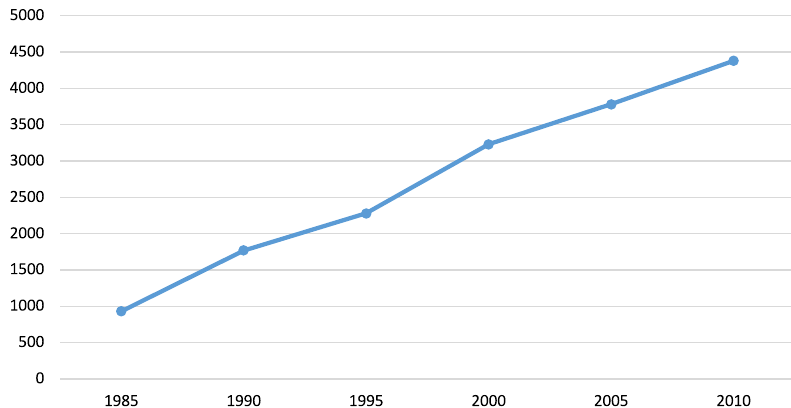
Fig. 1 GNI per capita, 1985 – 2010. Re fl ects the rise in the total domestic and foreign value added claimed by Jamaican citizens between 1985 and 2010 expressed in international dollars using purchasing power parity. GNI per capita provides an aggregate measure of income. Note: Data sourced from the World Bank (https://data.worldbank.org/country/jamaica). Table 5 Percentage of children under 5, underweight and overweight, 1991 –